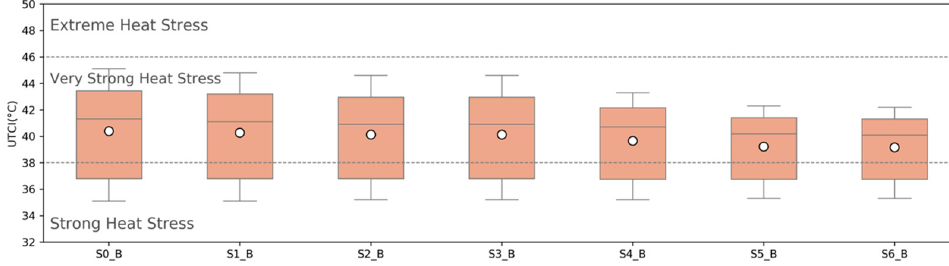
Figure 7. The UTCI level range of scenarios during simulation hours in deep street canyons (indexed as B).